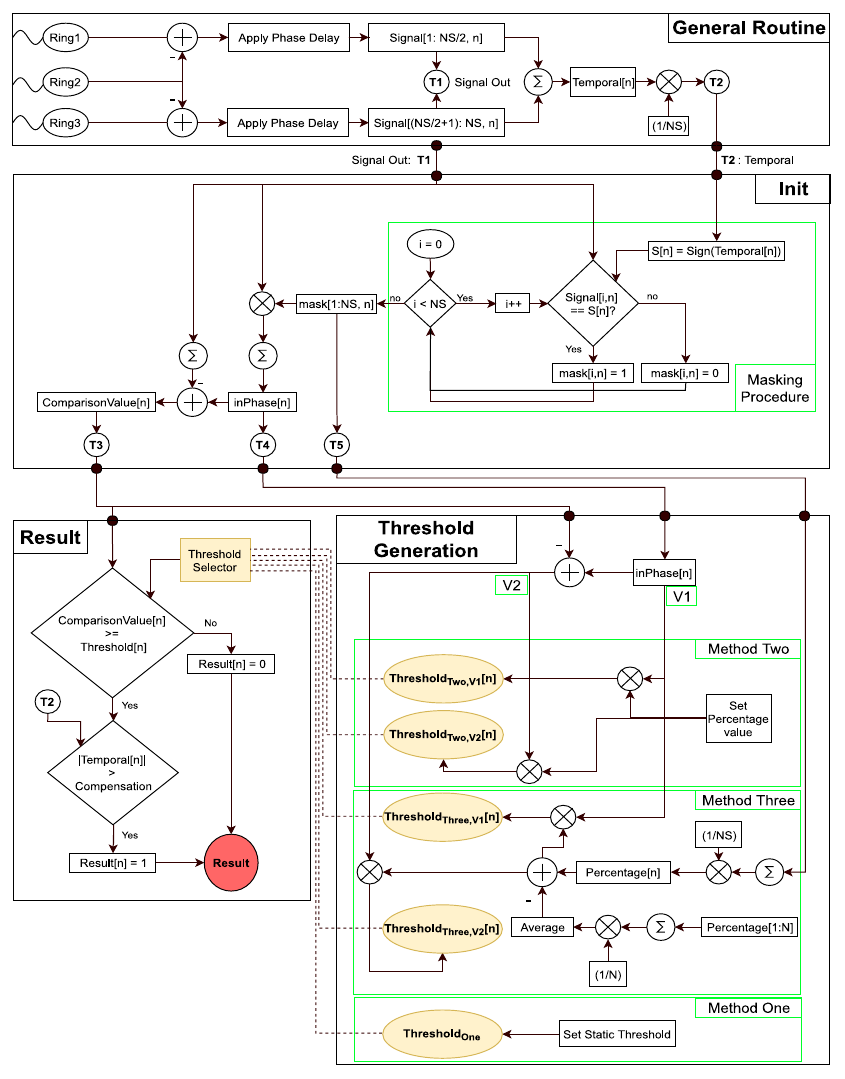
Figure 3. System flowchart.